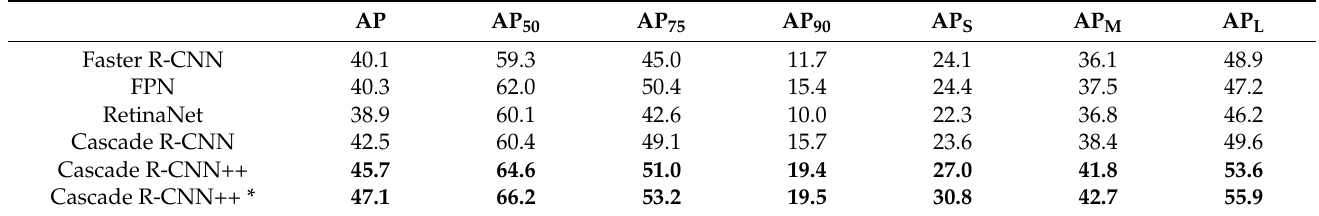
Table 4. Comparison with popular baseline detectors on DOTA-v1.5 dataset, all with Resnet-50 backbone. Entries denoted by * used enhancements of multi-scale training/inference and SoftNMS, as in